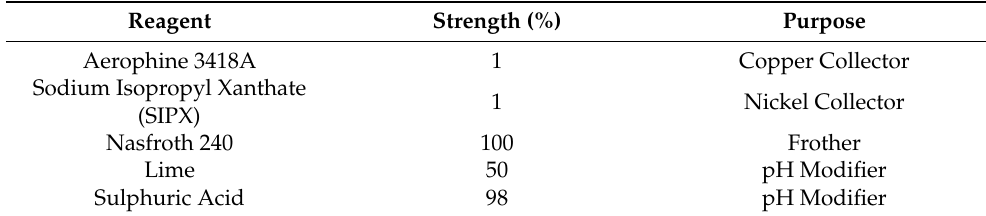
Table 2. Reagents and their solution strengths.